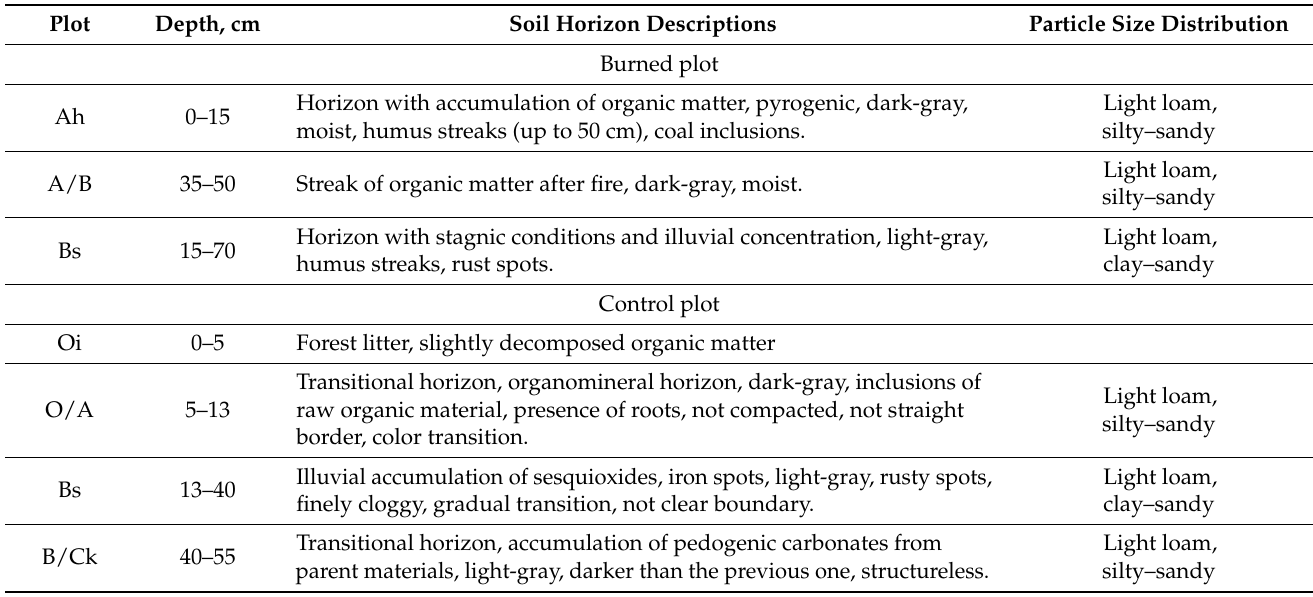
Table 1. Characteristics of studied soils.